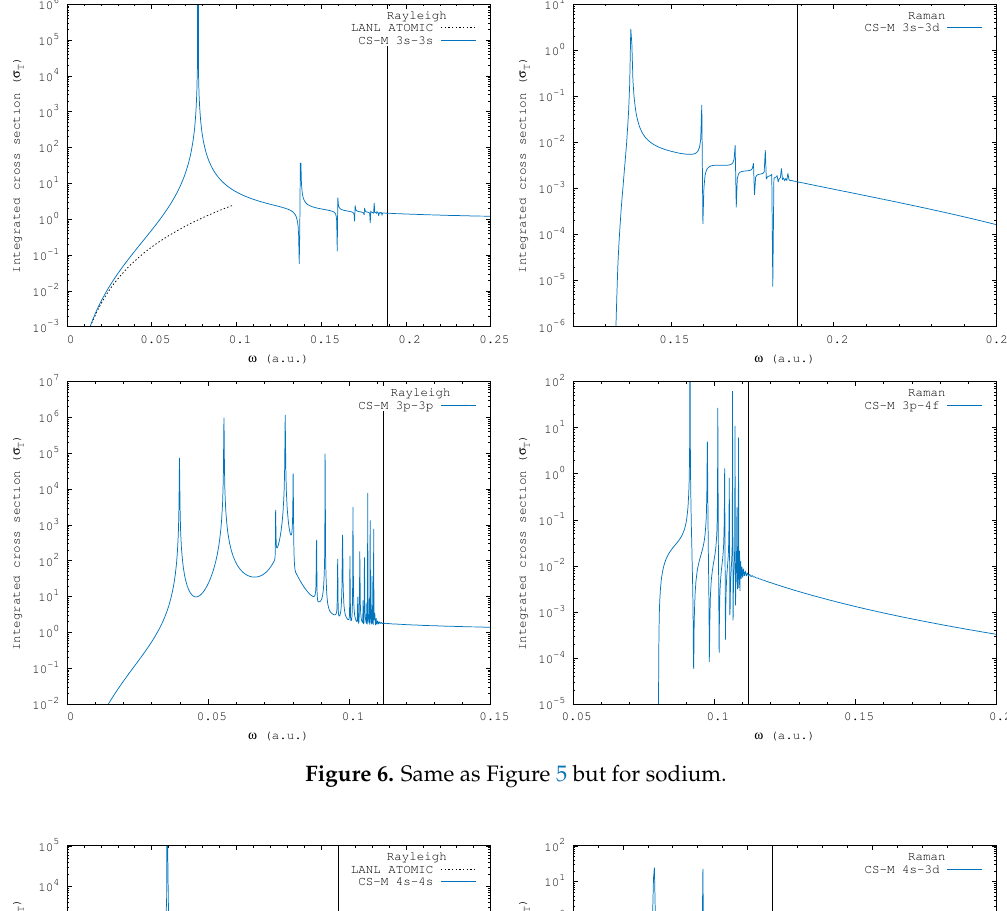
Figure 6. Same as Figure 5 but for sodium.